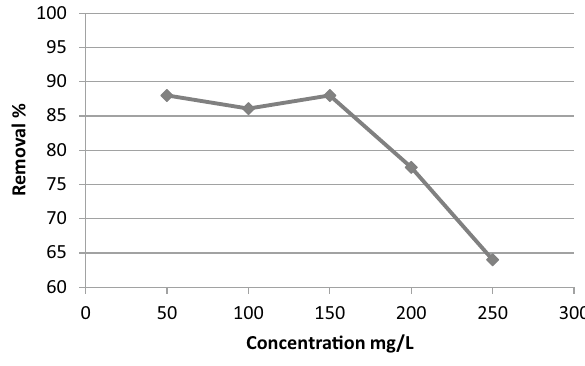
Fig. 10 The effect of contact time on CR